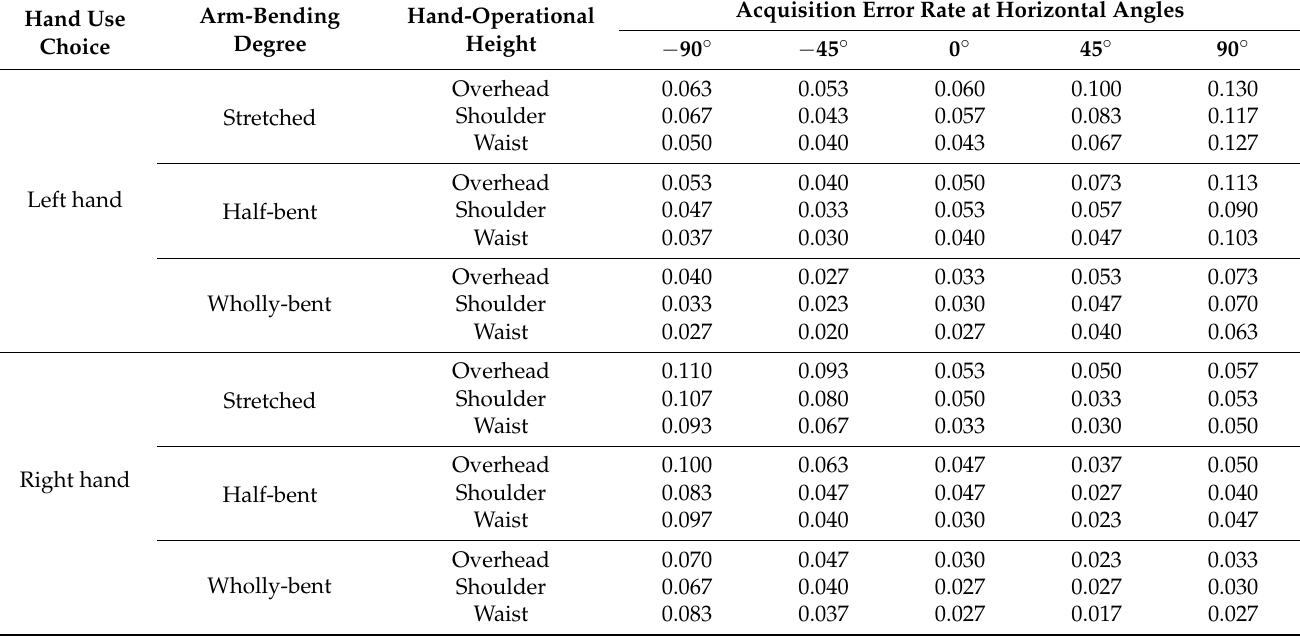
Table 2. Target acquisition error rates at different positions by either hand.